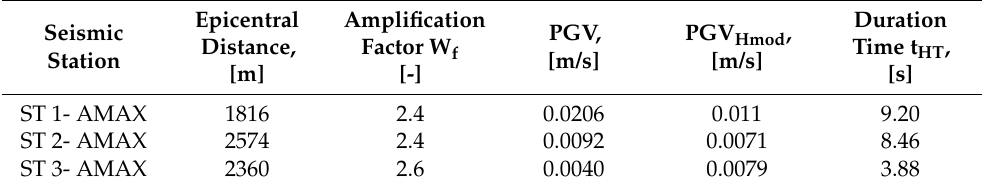
Table 3. Ground motion parameters at the point of registration by AMAX coal mine stations for the tremor of 8 November